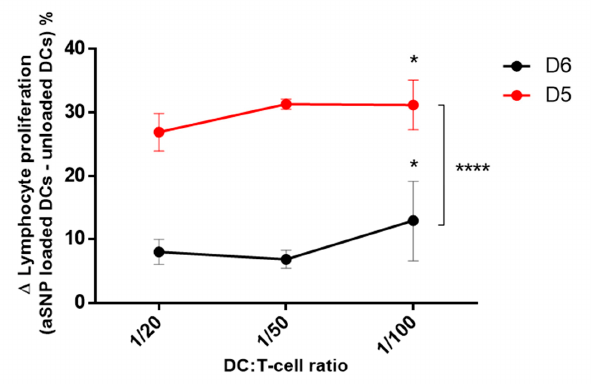
Figure 7. The 5-days incubation period is optimal to highlight lymphocyte proliferation augmentation induced by aSNP. Cells were incubated in the presence or absence of 12.5 µg.mL − 1 of aSNP for 16 hours. Treated MoDCs were co-cultured with allogeneic CD4+ T-cells labeled with CFSE at ratios of 1:20 (1 moDC for 20 CD4+ T-cells), 1 :50 and 1 :100). Proliferation was quantified after 5 or 6 days of co-culture as the percentage of CFSE low CD4+ T-cells. Untreated DCs were used as negative control. Results are showed as the Δ (aSNP loaded DC - unloaded DCs), corresponding to the proliferation of NP-treated DCs - proliferation of untreated DCs, and represent the mean ± SEM of three independent experiments. Tukey’s honest significance test was employed in conjunction with Two-way ANOVA *: statistically significant compared to 1:20 ratio with p < 0.05, **** : p < 0.0001.